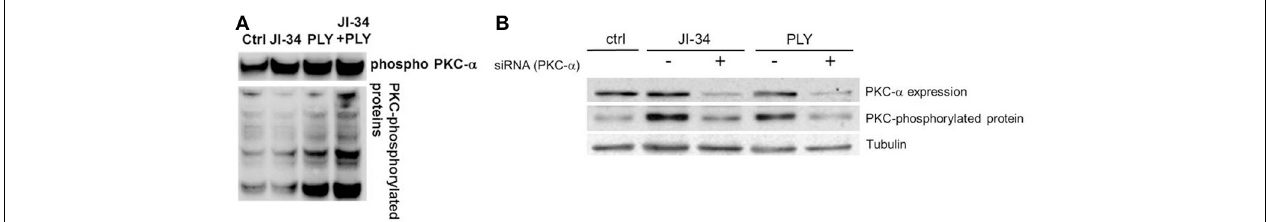
FIGURE 7 | (A) Expression of PKC-phosphorylated protein substrates in ctrl, PLY (30ng/ml), JI-34 (1 μ M), and JI-34 + PLY-treated HL-MVEC. Cells were pretreated for 30min with JI-34 and were then incubated for